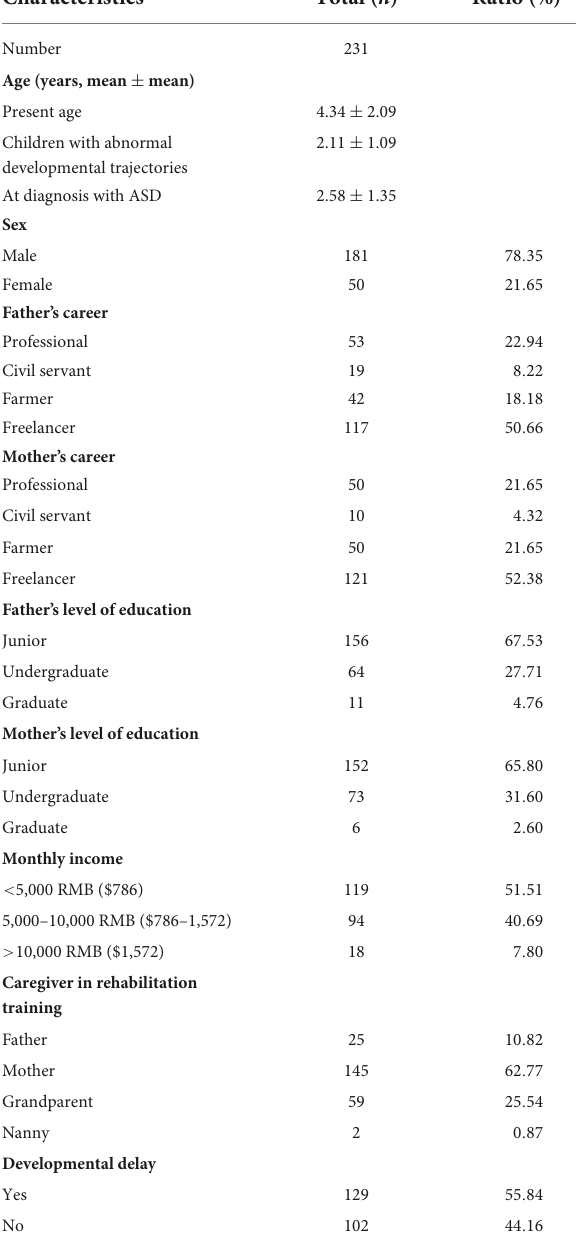
TABLE 1 Basic information of respondents ( n , %).